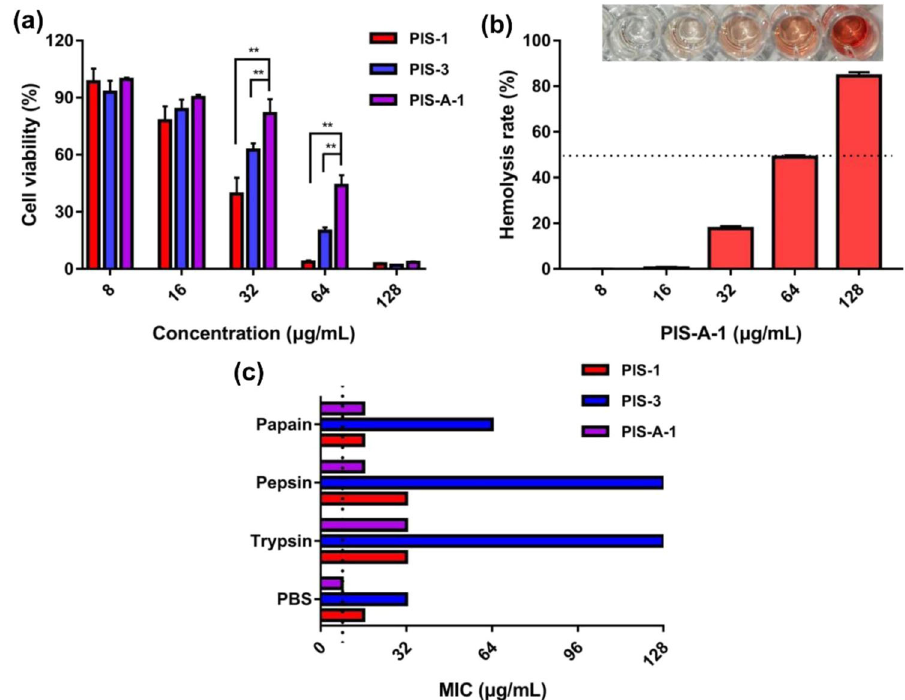
Fig. 3 Biocompatibility evaluation of PIS-A-1. a Cytotoxicity of PIS-A-1 against Caco-2 cells. b Hemolytic activity of PIS-A-1 on mouse blood cells; 0.1% Triton X-100 or PBS is used as positive (100% hemolysis) or negative (0% hemolysis) controls. c Protease stability in pepsin, papain, and trypsin ( fi nal molar ratio of PIS-A-1 vs protease of 300 ∶ 1). The error bars represent standard deviation ( n =